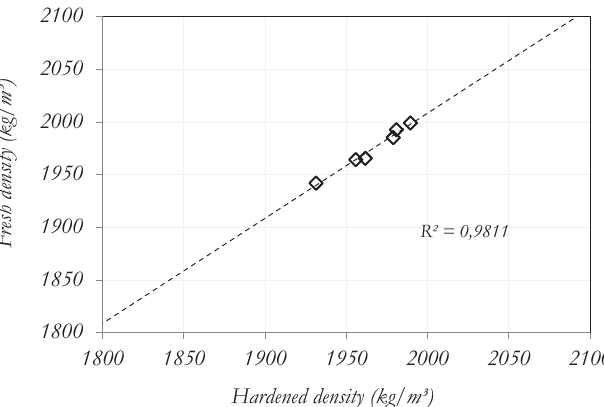
Figure 7 Hardened density vs. porosity of cast and cored